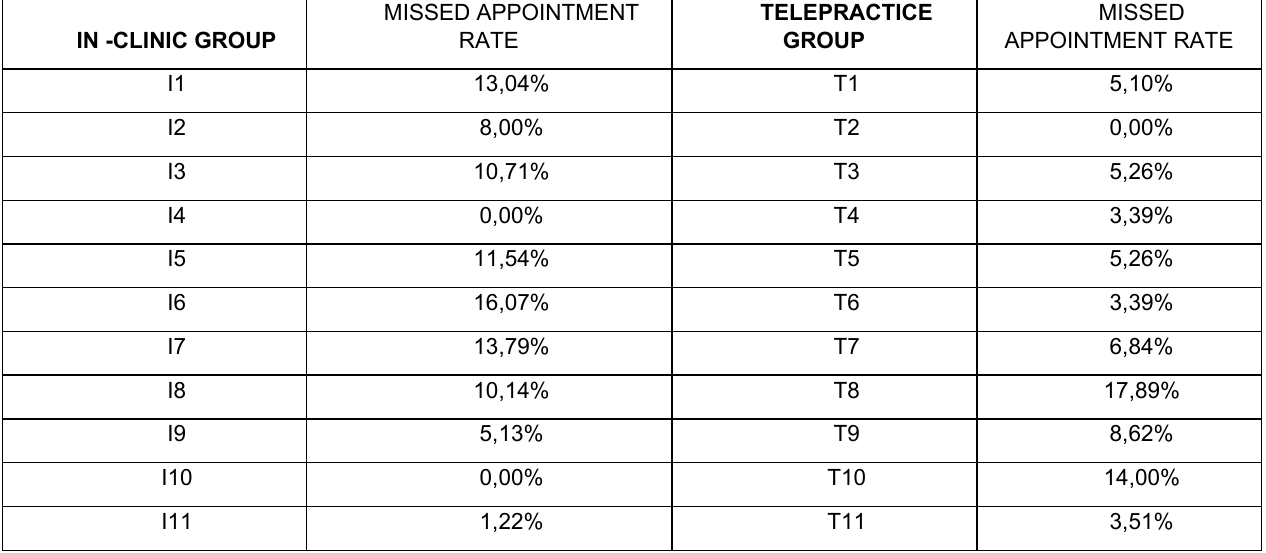
Comparison of the In-Clinic Group and Telepractice Group Missed Appointments Rate MISSED APPOINTMENT IN -CLINIC GROUP